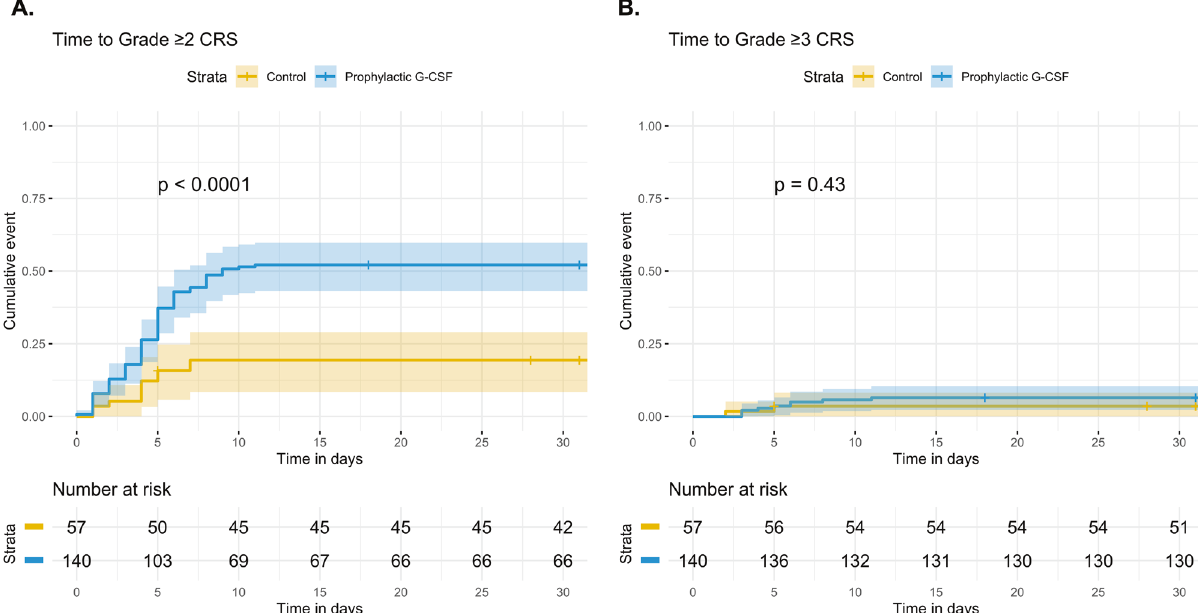
Fig. 2 Cumulative incidence of CRS in lymphoma patients treated with anti-CD19 CAR T cells. Time to grade ≥ 2 CRS ( A ) or grade ≥ 3 CRS ( B ) were estimated. Patients were strati fi ed by whether they received prophylactic G-CSF ( N = 140) or not (control, N = 57), and compared using the method of Gray. The cumulative incidence of grade ≥ 2 CRS was signi fi cantly greater in the prophylactic G-CSF group ( P < 0.01). In a multivariate Cox proportional hazards model, administration of prophylactic G-CSF prior to CAR T retained signi fi cance for increased risk of grade ≥ 2 CRS (HR 2.15, 95% CI 1.11 – 4.18, P = 0.02) (see Table 4). 95% con fi dence intervals are represented by